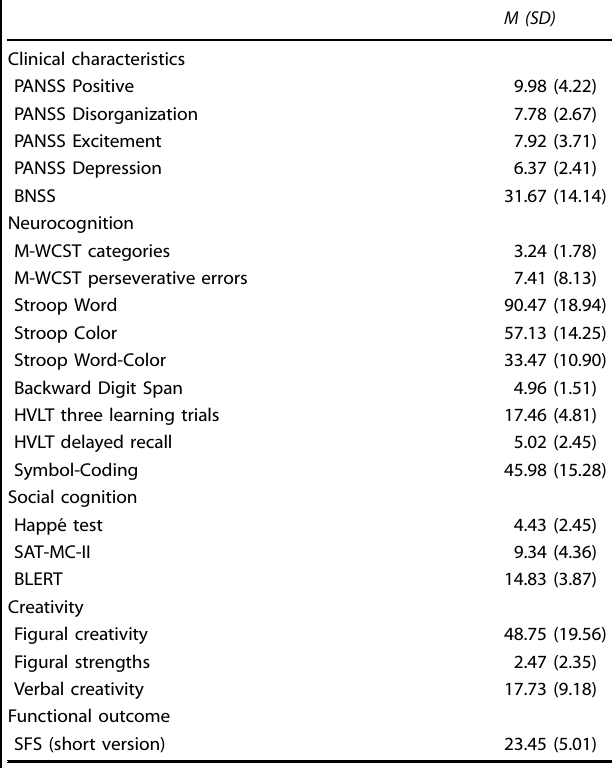
Table 1. Descriptive data of clinical, neurocognitive, social cognitive, creativity, and functional outcome measures.